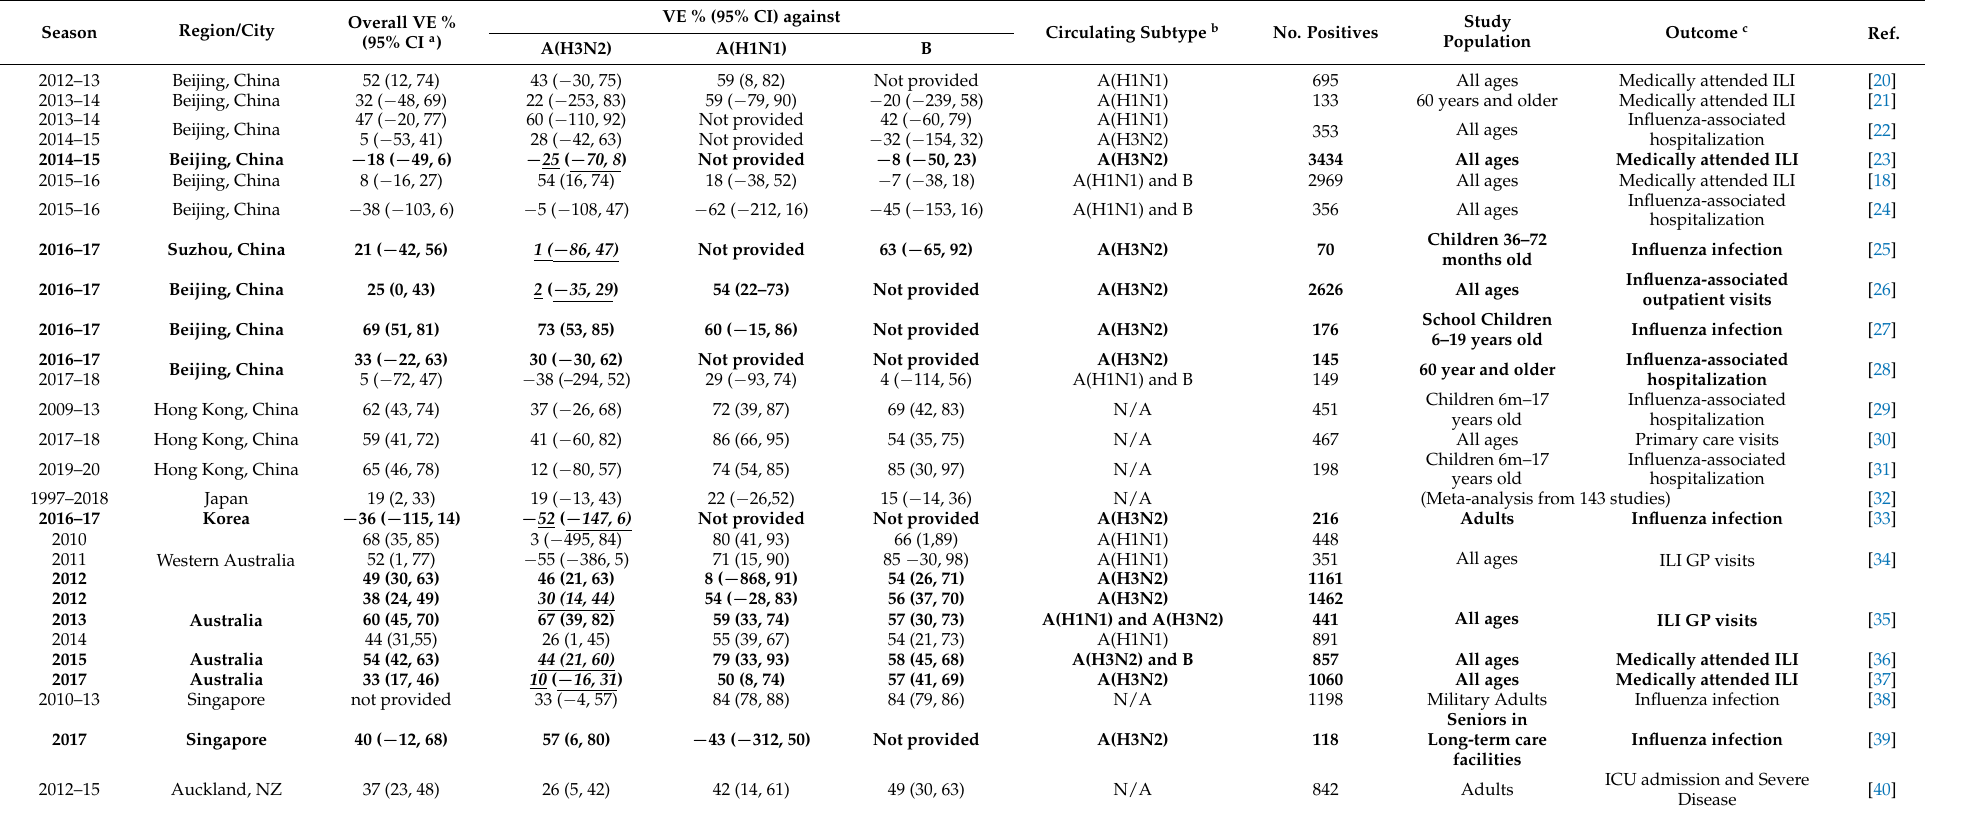
Table 3. Summary of studies reporting vaccine effectiveness (VE) against A(H3N2) during 2010–2020 in several Western Pacific countries. Studies conducted during which A(H3N2) was the dominant circulating subtype are highlighted in bold, and the relatively low A(H3N2) VE amongst subtypes are underlined. All studies, except the meta-analysis from Japan, used test-negative, case-control study